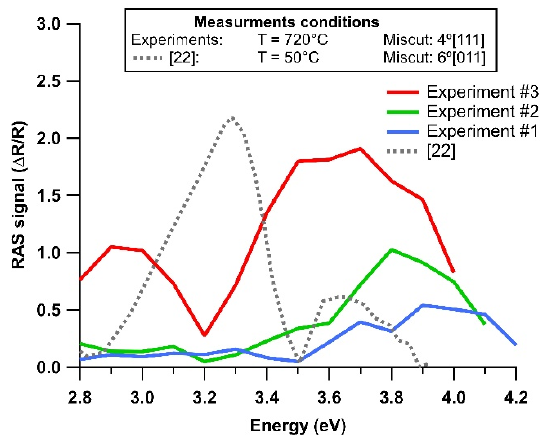
Figure 3. Reflectance anisotropy spectroscopy (RAS) of AsH 3 exposed Si (100) wafers under different experimental conditions. In dashed grey line the RAS signature from [22] is added for comparison.